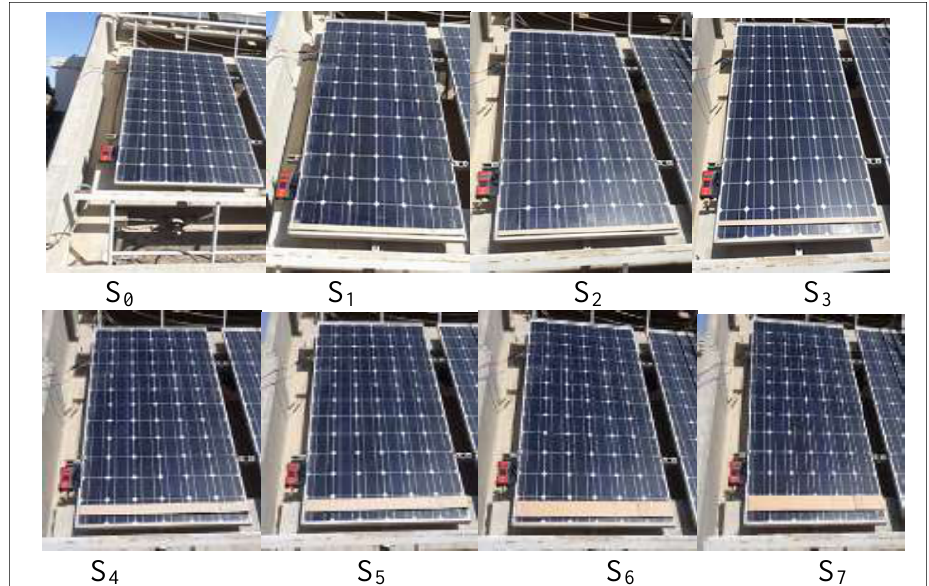
Figure 2. Photos of the shade at 10 AM.